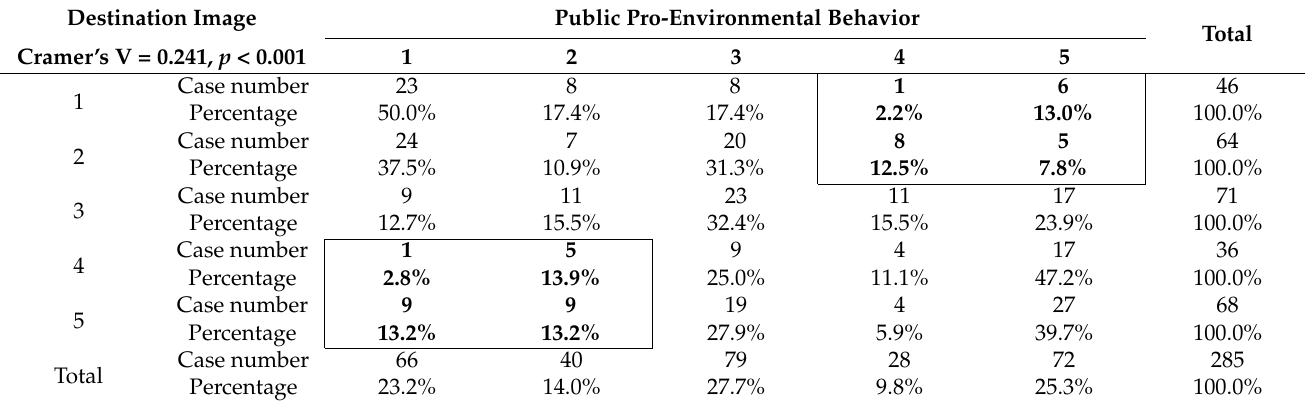
Table 12. Cross-contingency table of destination image and public pro-environmental